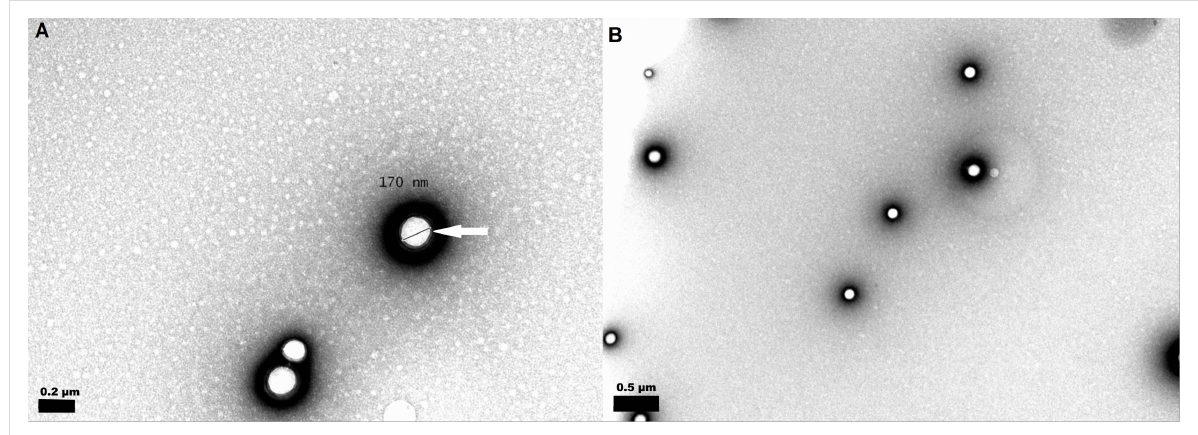
Figure 1: TEM images of (a) unloaded PLGA nanospheres, scale bar: 200 nm; and (b) loaded PLGA nanospheres, scale bar: 500 nm. The white arrow indicates the pluronic layer surrounding the PLGA NP.